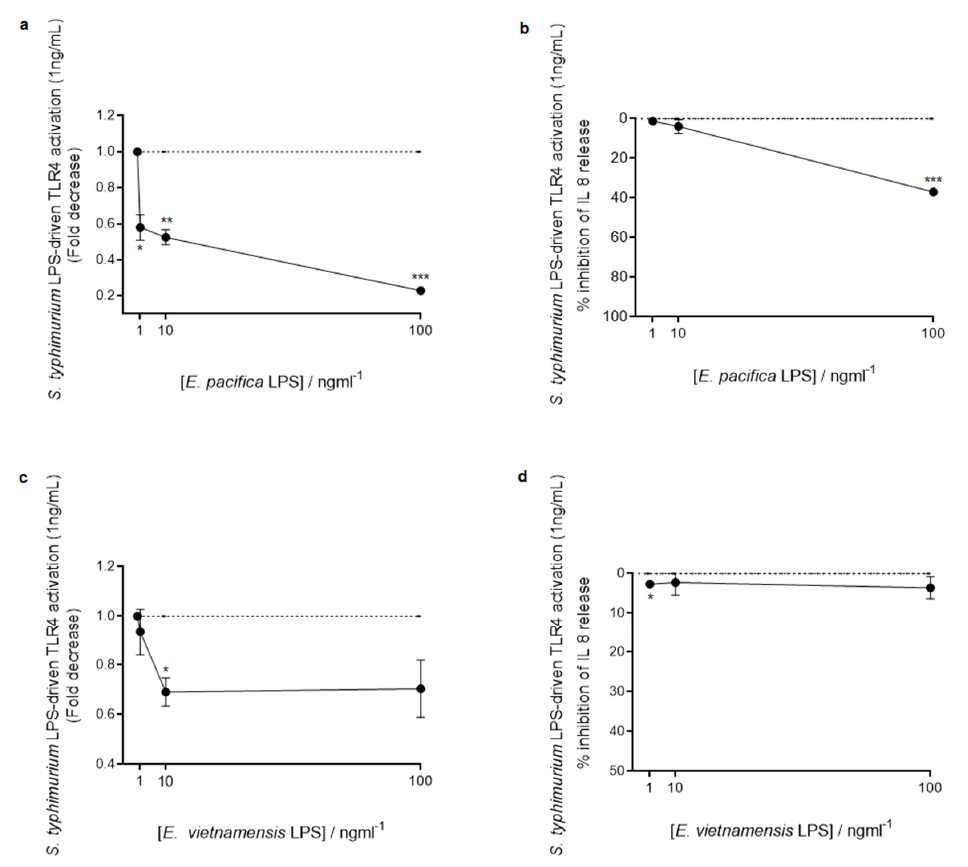
Figure 8. Competition assay. Fold decrease in NF- κ B ( a , c ) and inhibition percentage of IL-8 release ( b , d ) in HEK Blue TM hTLR4 cells pretreated with different concentrations (1, 10, and 100 ng/mL) of E. pacifica KMM 6172 T LPS ( a , b ) or E. vietnamensis KMM 6221 T LPS ( c , d ) and then stimulated with S. typhimurium LPS (1 ng/mL). Significant differences between the pretreatment with E. pacifica KMM 6172 T LPS or E. vietnamensis KMM 6221 T LPS and S. typhimurium LPS alone values are indicated. * p < 0.05, ** p < 0.01 and *** p < 0.001 by the Student’s t